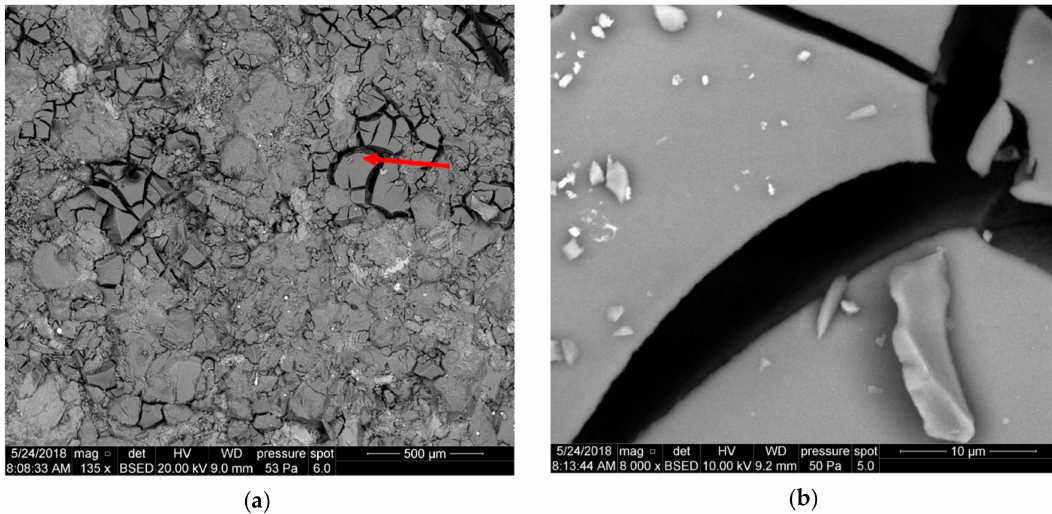
Figure 11. SEM image of the 3226 core face after contact with U-2, S.F. 2a, ( a ) top view of the core face, ( b ) top view of the core face at a high